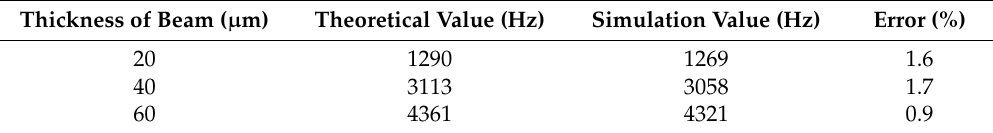
Table 4. The effects of the thickness of the beam on the resonant frequency.